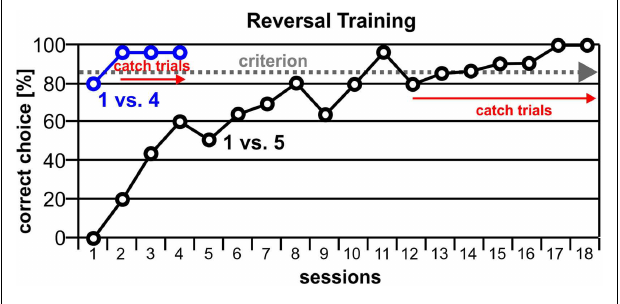
FIGURE 7 | Blue reached the criterion for the first reversal-training of 1 vs. 5 (85% correct choices) after 11 sessions, and in the following session the introduction of catch trials started. In the next session, performance dropped to 80% but recovered quickly. For the subsequently introduced training pair 1 vs. 4, criterion was already reached in the second session, and performance remained constant even after the introduction of catch